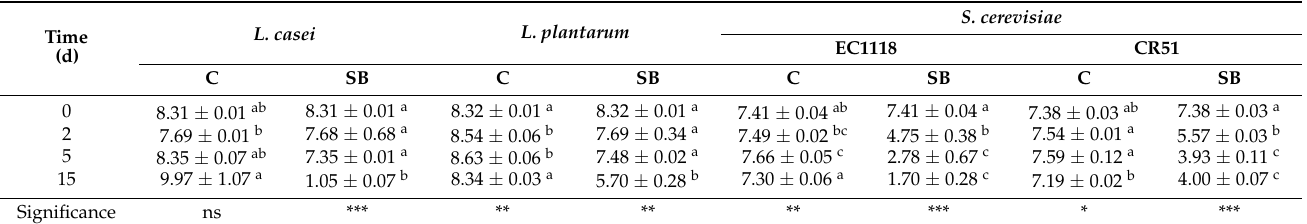
Table 4. Effect of encapsulated sodium benzoate (TC/SB-SG) on inactivation of spoilage microorganisms (log CFU/mL) of orange juices during 15 days of storage at 5 ◦